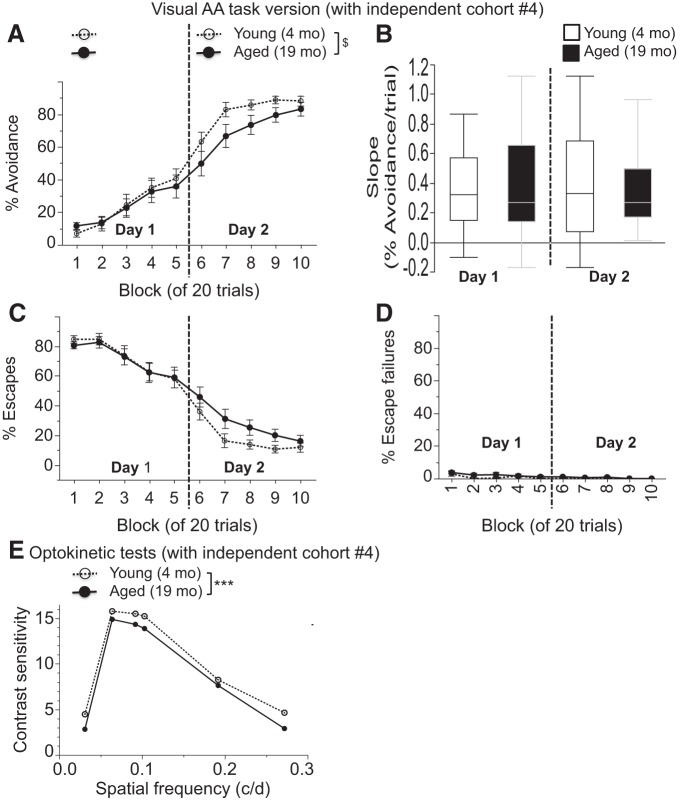
A–E, Active avoidance (A–D) and optokinetic testing (E) in an independent cohort. Visual active avoidance is mildly impaired in 19-month-old mice. A, The percentage of successful active avoidance trials is shown in blocks of 20 trials over the 2 day test period for the visual version of the task. B, Slopes of the percentage of avoidance per trial are shown for both AA training days. C, D, The percentages of escapes (C) and escape failures (D) are shown in blocks of 20 trials over the 2 day test period. E, Contrast sensitivity from optokinetic tests is shown across varying spatial frequencies (in c/d). Values are expressed as the mean ± SEM. SEMs are not visible in E since they range from only 0.014 to 0.092 across age groups and spatial frequencies. $p < 0.1, ***p < 0.0001.